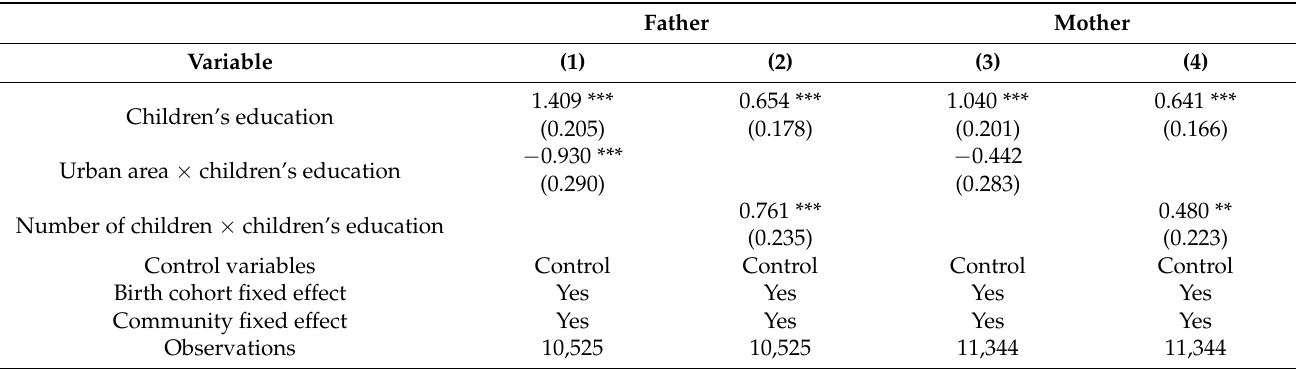
Table 7. Results of the heterogeneity